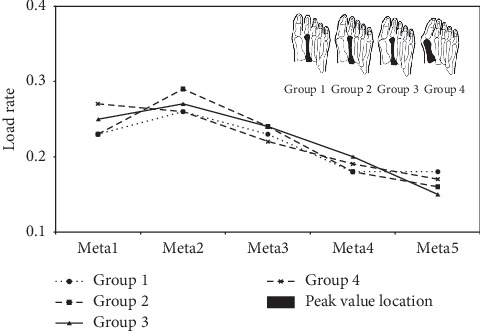
Load rate of five metatarsal regions in four different groups.